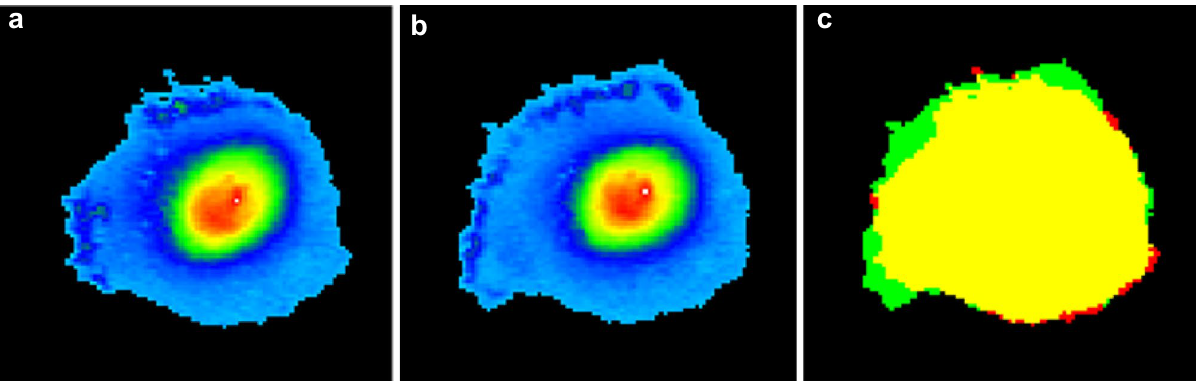
Figure 4. Illustration of protrusions and retractions for one cell from movie related to Fig. 3. ( a ) The cell at time-point 371 min; ( b ) the same cell at time point 381 min and ( c ) superimposed outlines with the protrusion in green and retraction in red. The field size is 128 × 135 µm. The common area occupied in both frames is in yellow. The green protrusion is the newly allocated area in the frame ( b ), and the red retraction is the withdrawn area allocated in the frame ( a ), which is no longer allocated in ( b